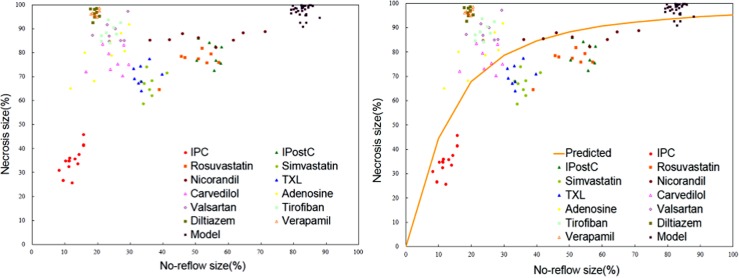
Scatterplot for observational values of necrosis and no-reflow sizes in the model group and all intervention groups.
A: Scatterplot for necrosis sizes and no-reflow sizes; B: Scatterplot and established model. Under similar no-reflow sizes, differences in necrosis size existed with different interventions. Diltiazem and verapamil reduce no-reflow size and necrosis size to a similar degree. IPC, verapamil and diltiazem reduced no-reflow size to a similar degree, but IPC caused a greater decrease in necrosis size than diltiazem or verapamil.